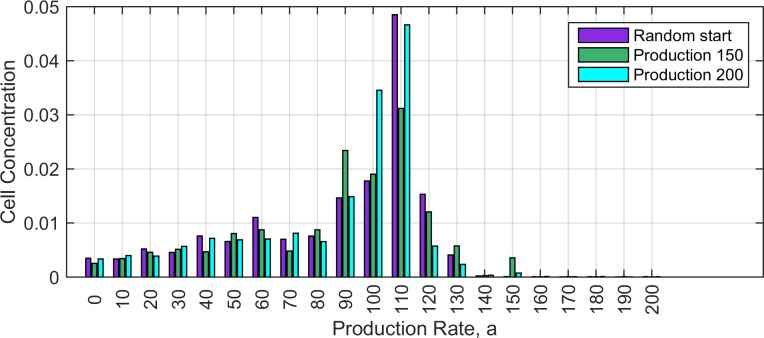
Time averaged cell concentrations in simulations with mutations between producers of many different production rates.Three sets of initial conditions are described in the text. These converge to similar distributions in the long-time limit. Simulations were run for 100,000 time units and an average was taken over the second half of the simulation. Parameters: b = 10, c = 0.001, δt = 0.01, u = 0.0001, lattice: L = 1024x1024. The equilibrium concentration of S in these runs is close to 0.32.